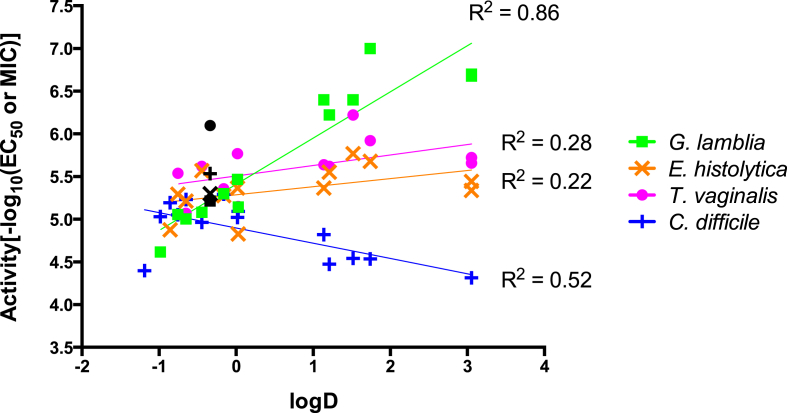
Activity vs logD of active 4(5)-nitroimidazoles. Compounds were classified as active against G. lamblia and E. histolytica with EC50 < 50 μM and were considered active against T. vaginalis with EC50 < 20 μM. All 4(5)-nitroimidazoles were classified as active against C. difficile (MIC ≤ 16 μg/mL). Metronidazole (black symbols) is shown for comparison.